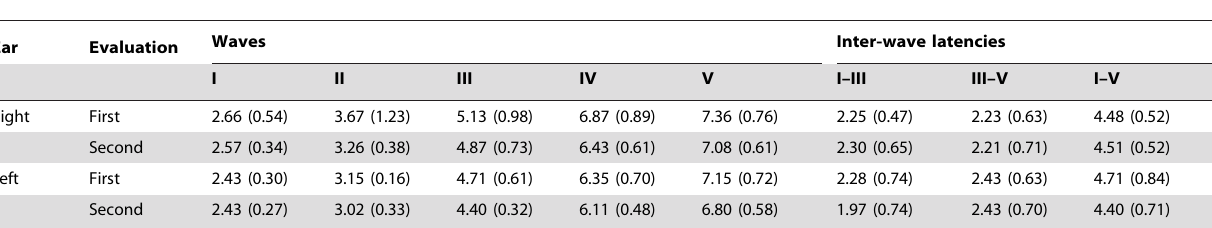
Table 1. Auditory Brain Responses